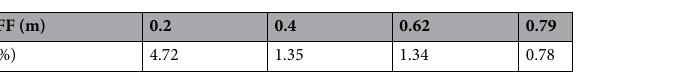
Table 8. The error indexes corresponding to different